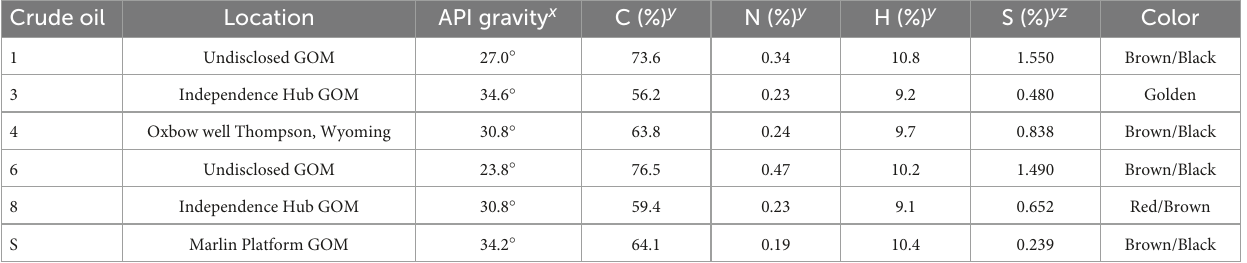
TABLE 1 Physical and chemical characteristics of crude oil samples, x: API gravity > 31.1 ◦ denotes a light crude oil and API gravity 22.3–31.1 ◦ denotes a medium crude oil, y: % mass, z: crude oils with > 0.5% sulfur content are considered sour, while < 0.5% sulfur are considered sweet, GOM: samples collected in the Gulf of Mexico.